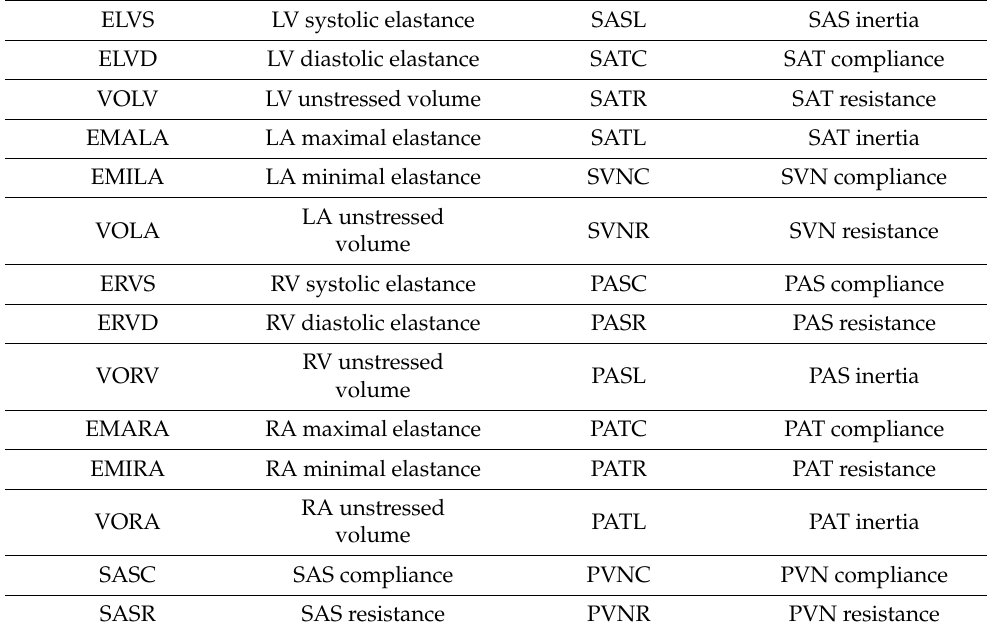
Figure 4. Model parameter sensitivity percentages. Table 3. Legend for sensitivity analysis